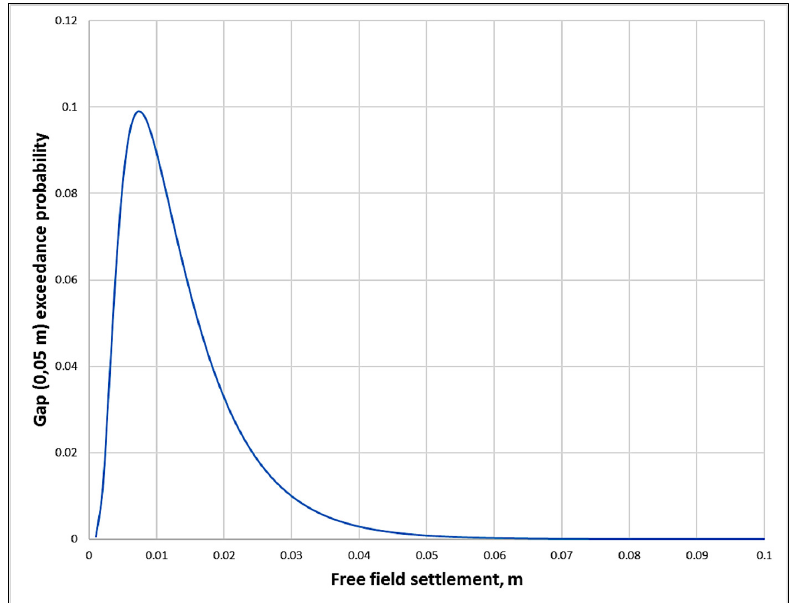
Figure 9. Exceedance probability distribution function of the gap versus settlement at the free field.